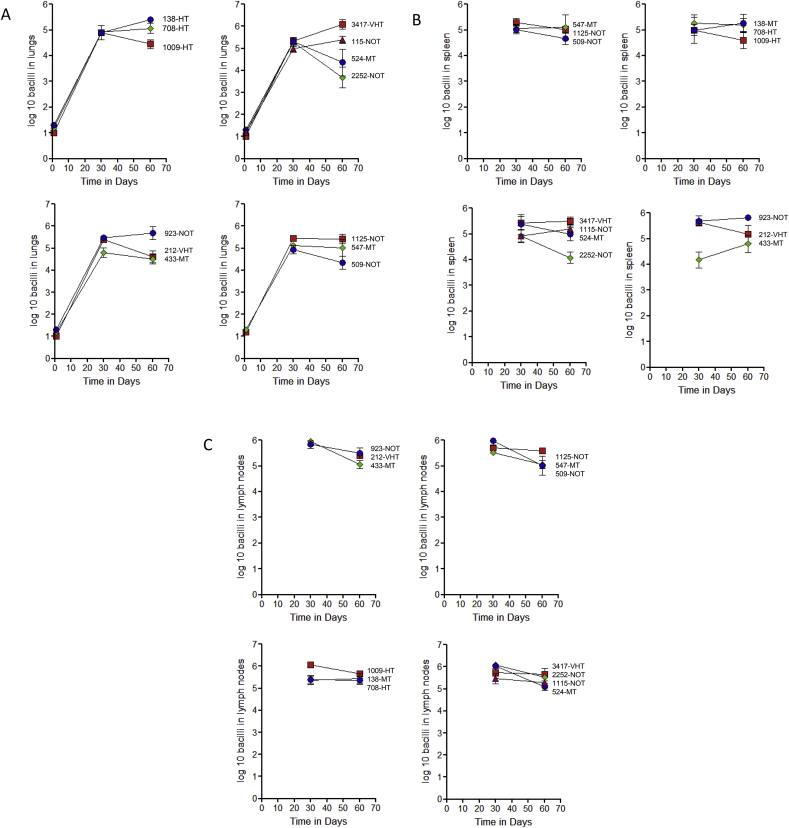
Growth of unique [NOT; no observed transmission], moderate transmission [MT], high transmission [HT] and very high transmission [VHT] clinical isolates of M. tuberculosis in the lungs of guinea pigs after deposition of approximately 15–20 bacilli by aerosol exposure. Data is shown as mean values from five animals per time point ±SEM, in the lungs [Fig. 1A], spleen [Fig. 1B], and draining lymph nodes [Fig. 1C].